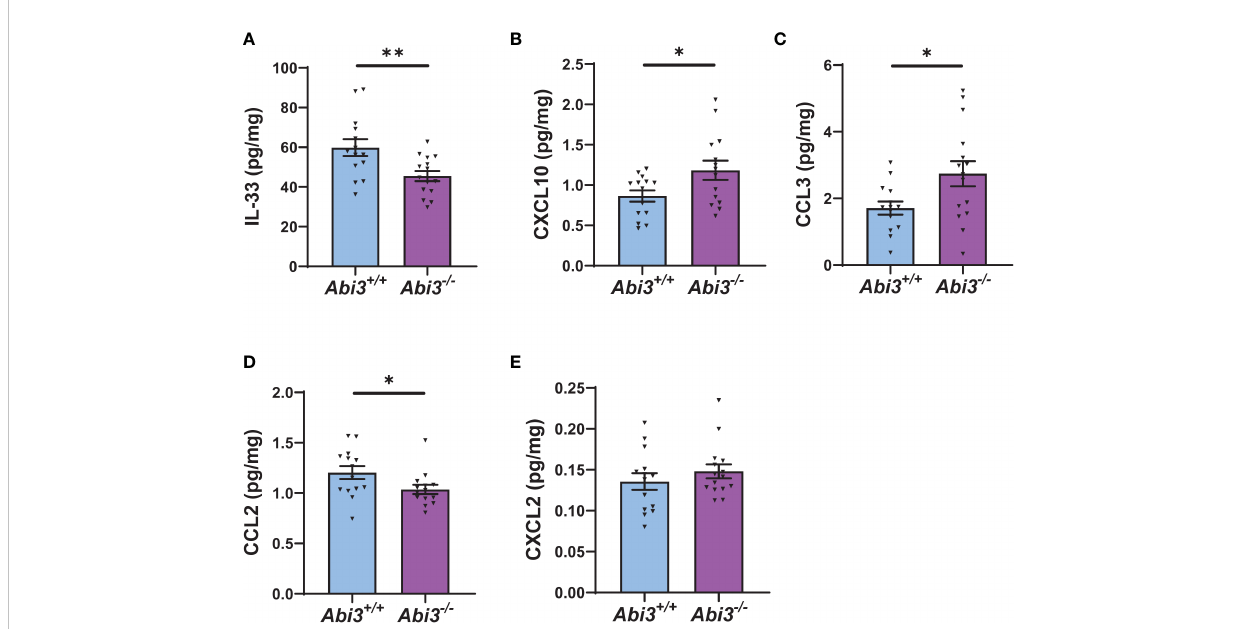
FIGURE 4 Deletion of the Abi3 locus alters the levels of secreted cytokines in 5XFAD mice. Protein levels of cytokines were measured in the PBS fraction of 4.5-month-old 5XFAD mouse cortices using the MSD mouse cytokine panel. (A) IL-33, (B) CXCL10, and (C) CCL3 were signi fi cantly increased, whereas (D) CCL2 was decreased in Abi3 -/- mice compared to Abi3 +/+ mice. (E) CXCL2 levels did not change between the genotypes. All data were normalized by total protein level and given as mean ± SEM (n=14-15). Unpaired two-tailed t-test, * p < 0.05, ** p <